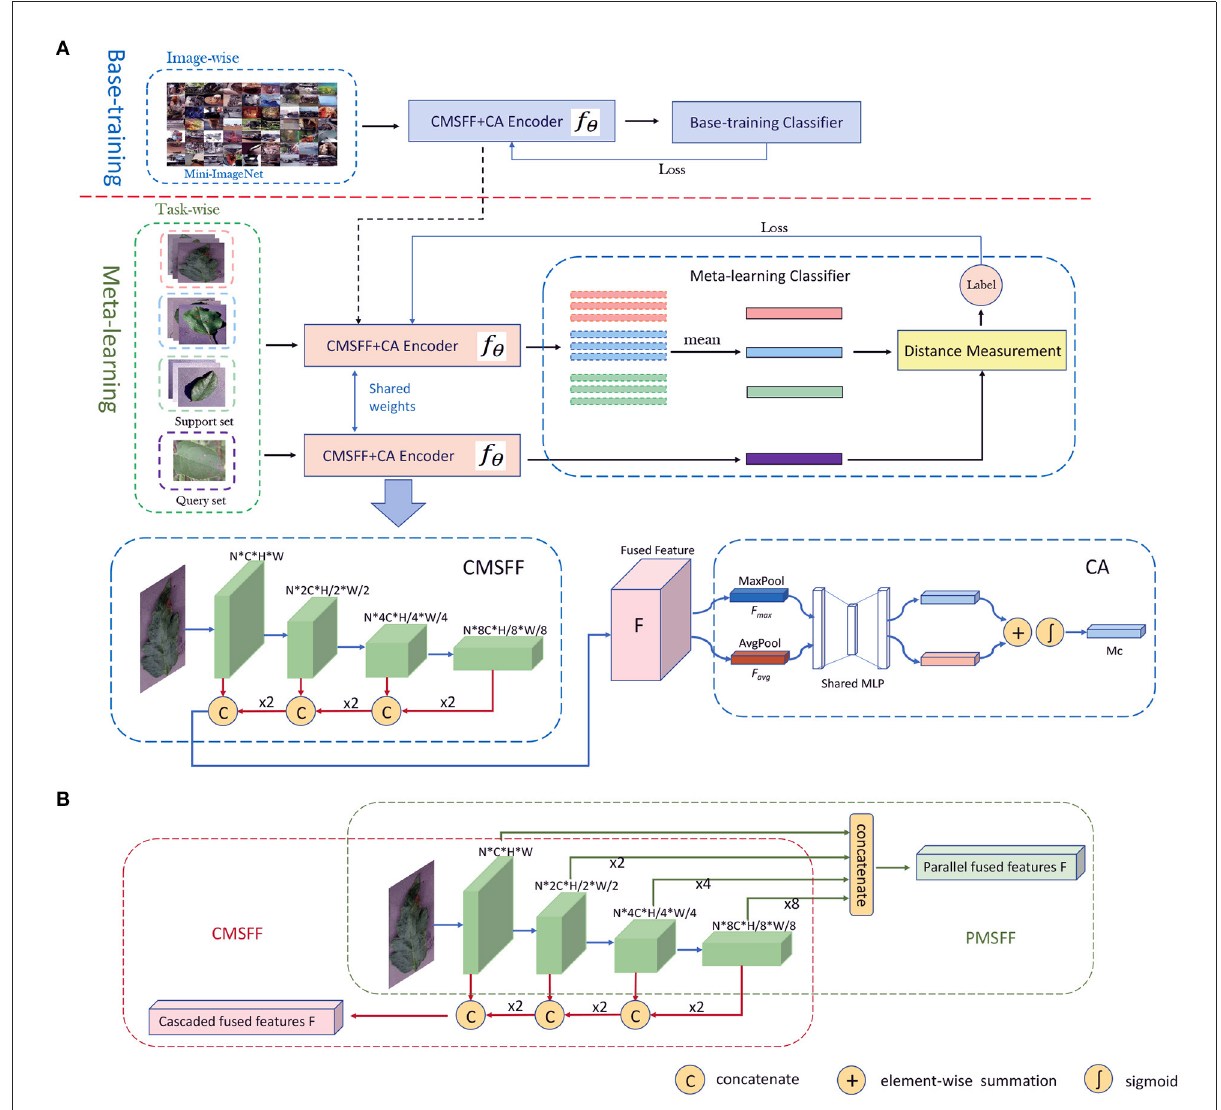
FIGURE2 (A) The network architecture of our method. The training includes two stages: base-training stage and meta-learning stage. The CMSFF+CA Encoder is unfolded to CMSFF module and CA module. (B) The parallel multi-scale feature fusion and cascaded multi-scale feature fusion.